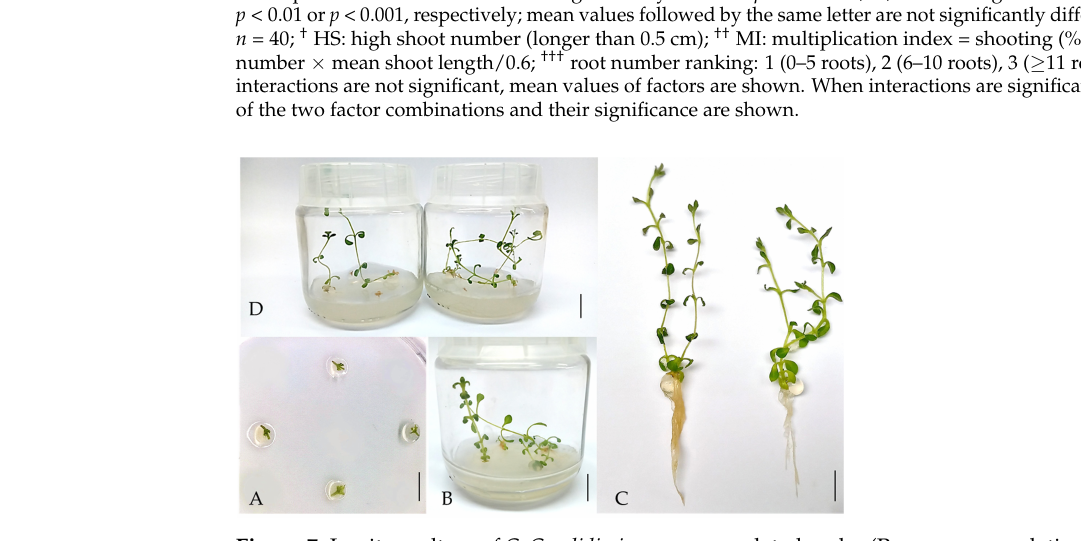
Figure 7. In vitro culture of C. Candidissimum encapsulated nodes (Parnassos population) on hor- mone-free (Hf) Murashige and Skoog media (MS): ( A ) encapsulated nodes; ( B ) a 50-day growth (E0d treatment); ( C ) rooted plantlets converted during a 50-day growth (E30d treatment); ( D ) a 50-day growth (E60d treatment). Bars represent a length of 1.0 cm. E0d: encapsulated node storage for 0 days at 4 °C; E30d: encapsulated node storage for 30 days at 4 °C; E60d: encapsulated node storage for 60 days at 4 °C.